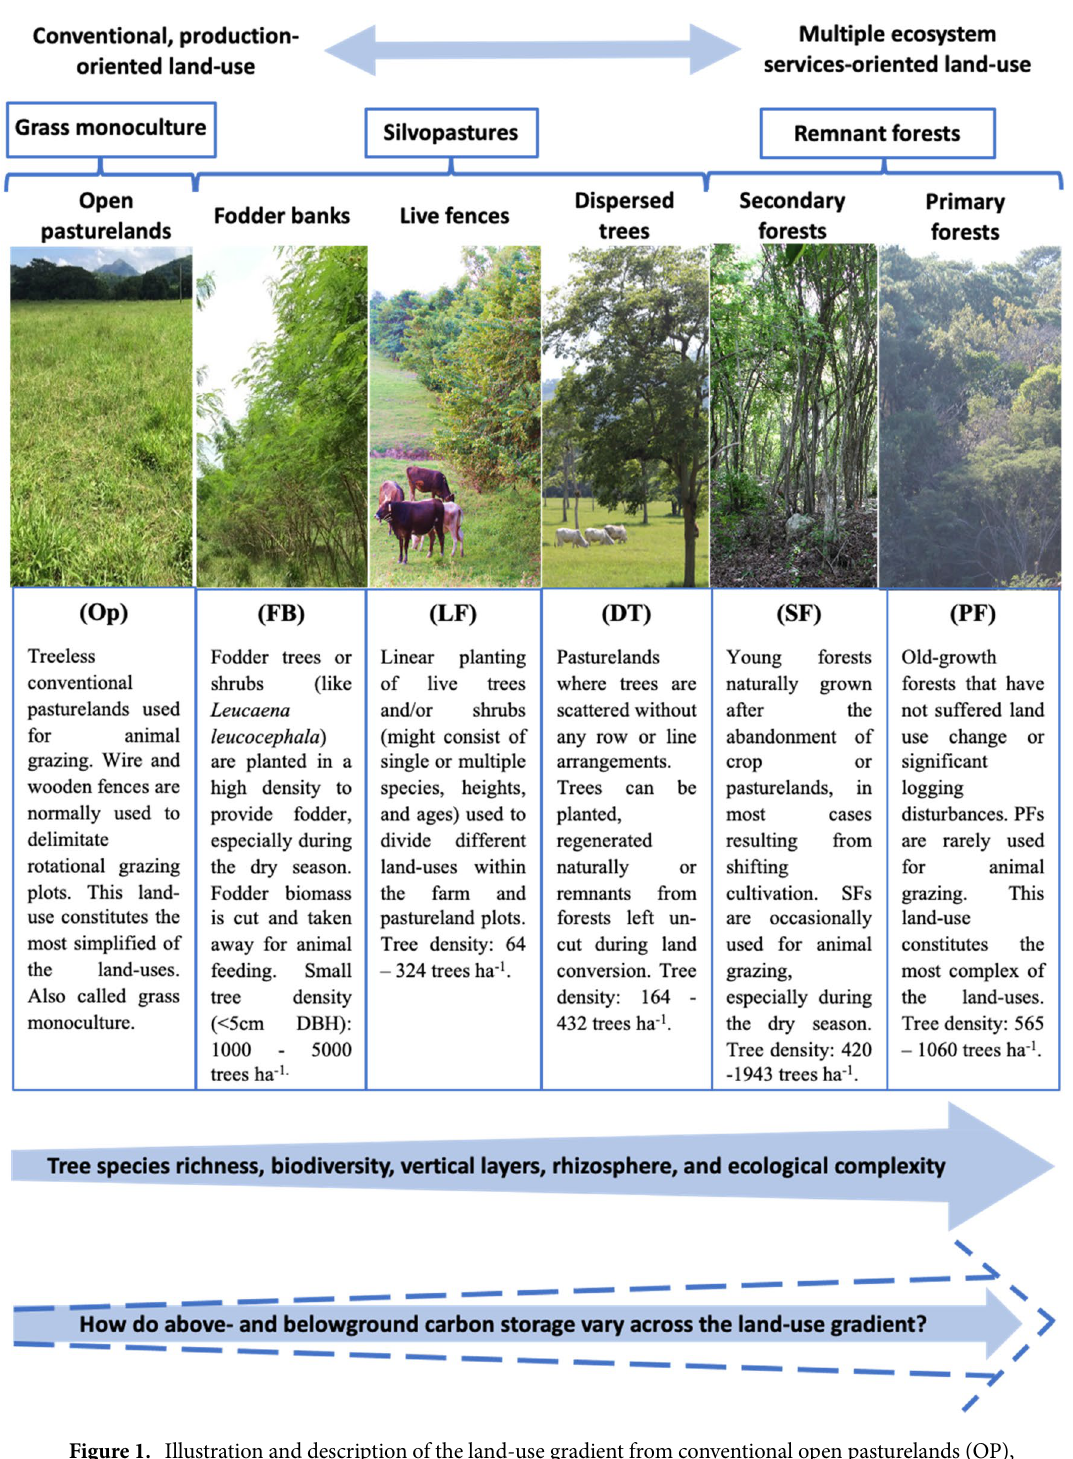
Figure 1. Illustration and description of the land-use gradient from conventional open pasturelands (OP), fodder banks, (FB) live fences (LF), pasturelands with dispersed trees (DT), secondary forests (SF) to primary forests (PF) selected for carbon monitoring. Land-uses followed an intensity gradient from ecologically simple to complex systems. The photographs were taken by Deb Raj Aryal from Chiapas (OP, FB, DT, PF) and Campeche (SF), Mexico. The animals in the images were to represent that the lands we sampled are used for animal